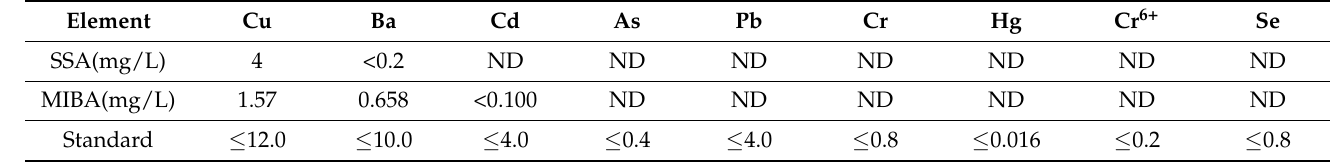
Table 3. TCLP test results for MIBA and SSA.